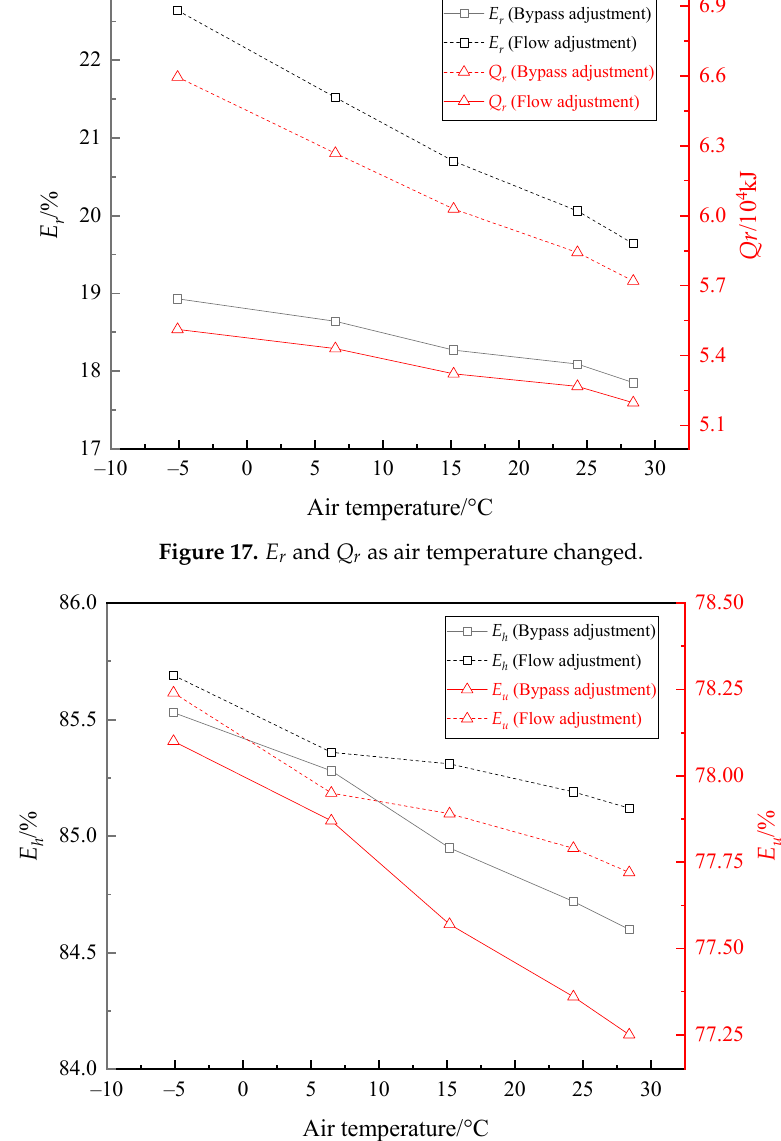
Figure 19. EGT as air temperature changed. If the flue gas temperature is much higher or lower than the required EGT when the ambient temperature changes, the percentage of bypass gas flow and water flow of AE should be increased simultaneously when the EGT is too high and be reduced when the EGT is too low. 6.4. Adjustment of the Improved LTE–FAH System Assuming that the designed EGT of the LTE is t g , the designed inlet liquid temperature of the of the LTE is t w , the actual EGT is t g,o , and the actual inlet liquid temperature is t 1 , there may be the following four cases in the operation of LTE–FAH system: (1). t g,o > t g , t 1 > t w ; (2). t g,o > t g , t 1 < t w ; (3). t g,o < t g , t 1 > t w ; (4). t g,o < t g , t 1 < t w .